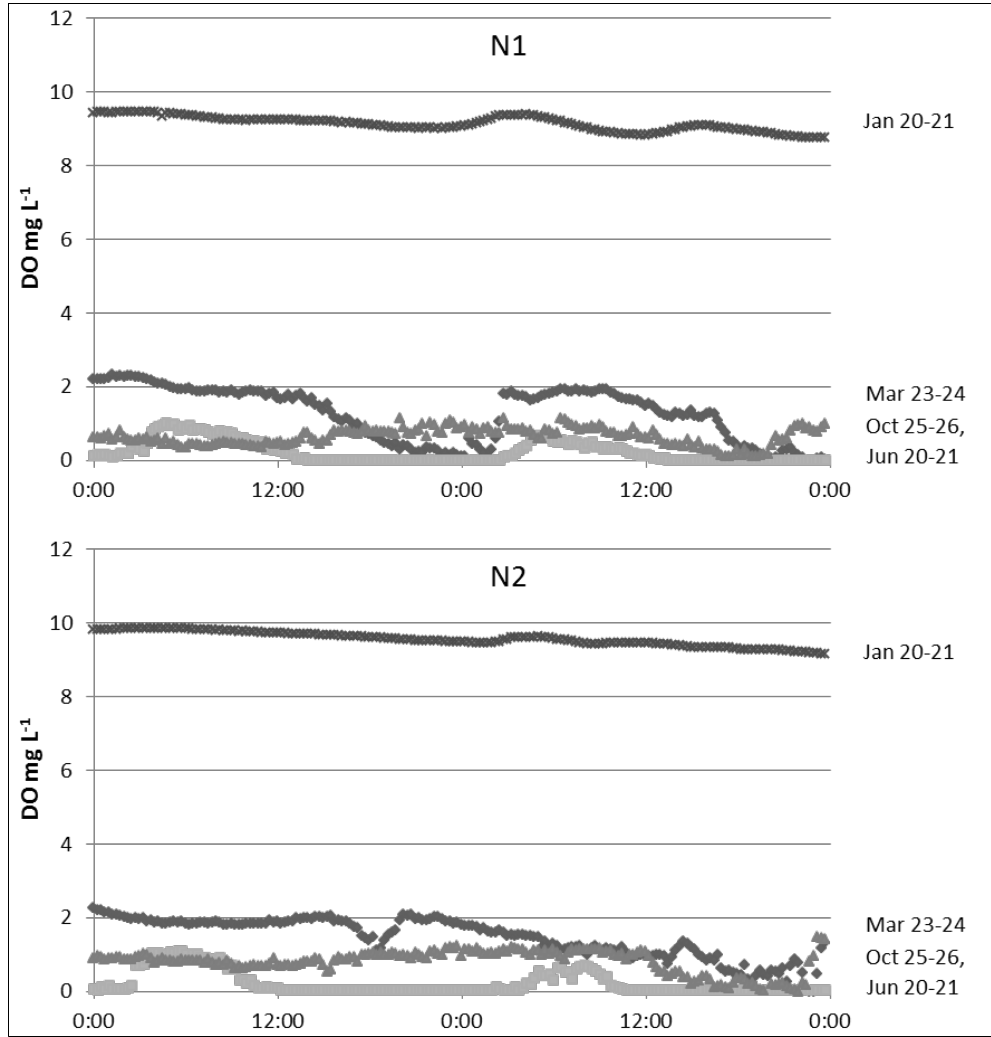
Figure 5. Diel trends of dissolved oxygen concentration (mg L −1 ) at ( N1 ) and ( N2 ) over two-day periods in the spring, summer, fall, and winter of